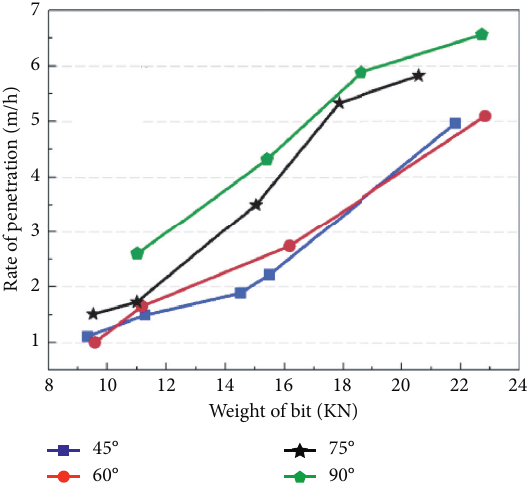
Figure 28: Relationship between WOB and ROP with α change of bits